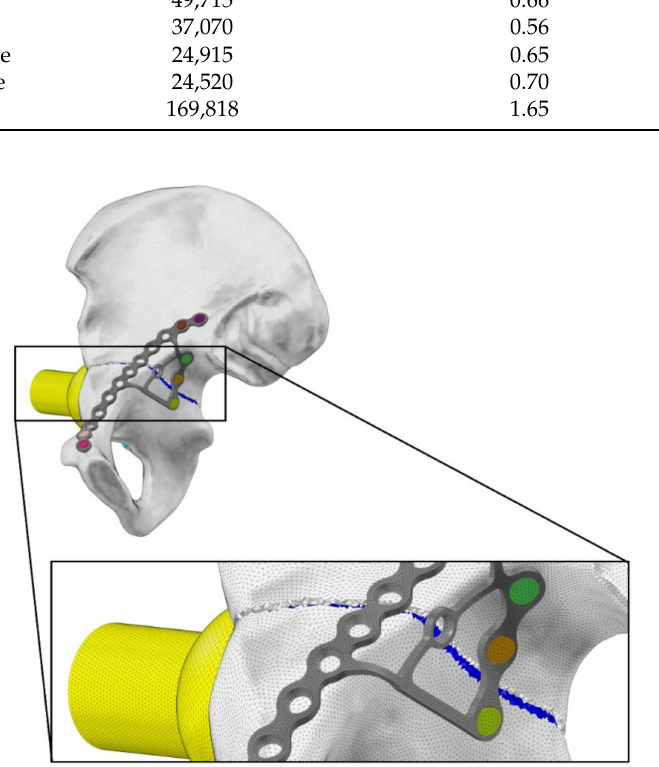
Figure 4. Mesh generated with a zoomed detail of the fractured region. The SQBP C1 plate-screw model implanted on a transverse fracture is shown as a